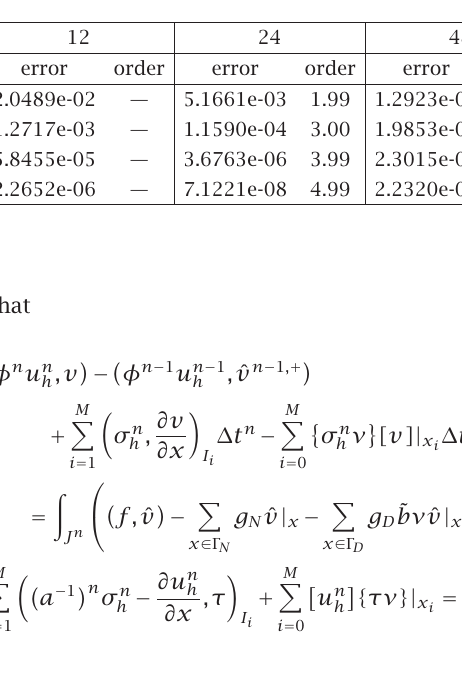
Table 8.1 . The estimates for u